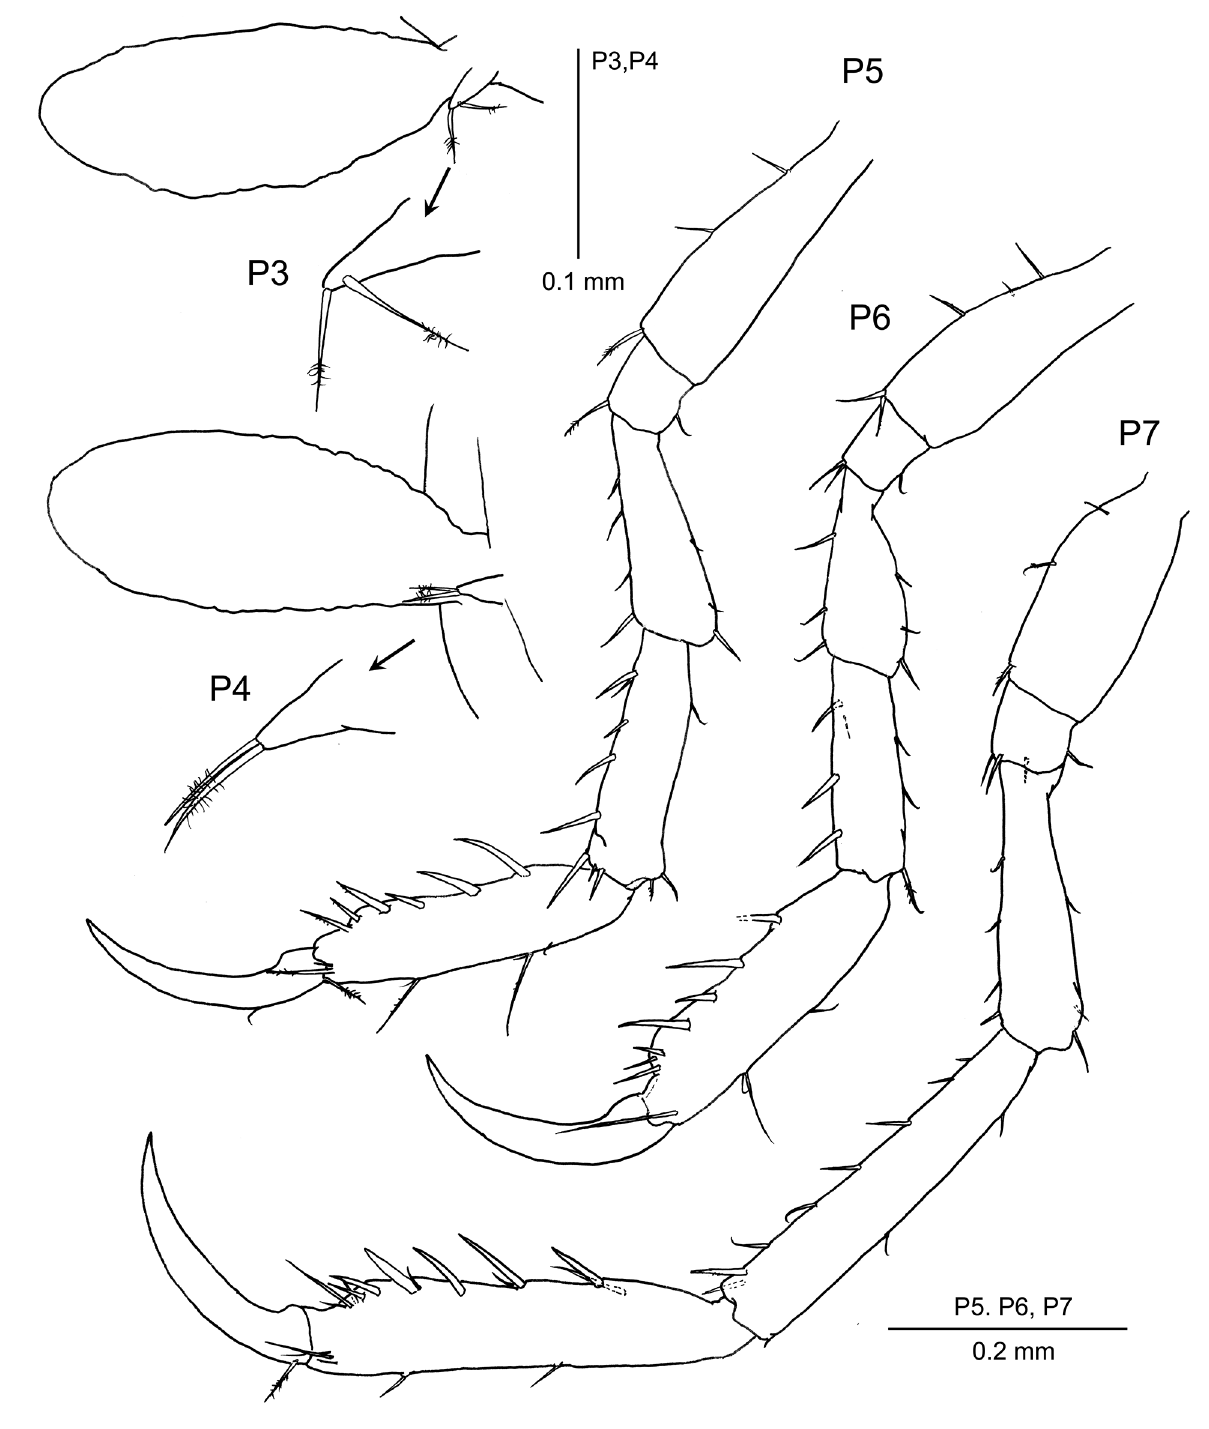
Figure 5. Parapseudaeginella australiensis n. sp. Pereopods 3–7 of holotype male (WAM C76110). Abbreviation: P =